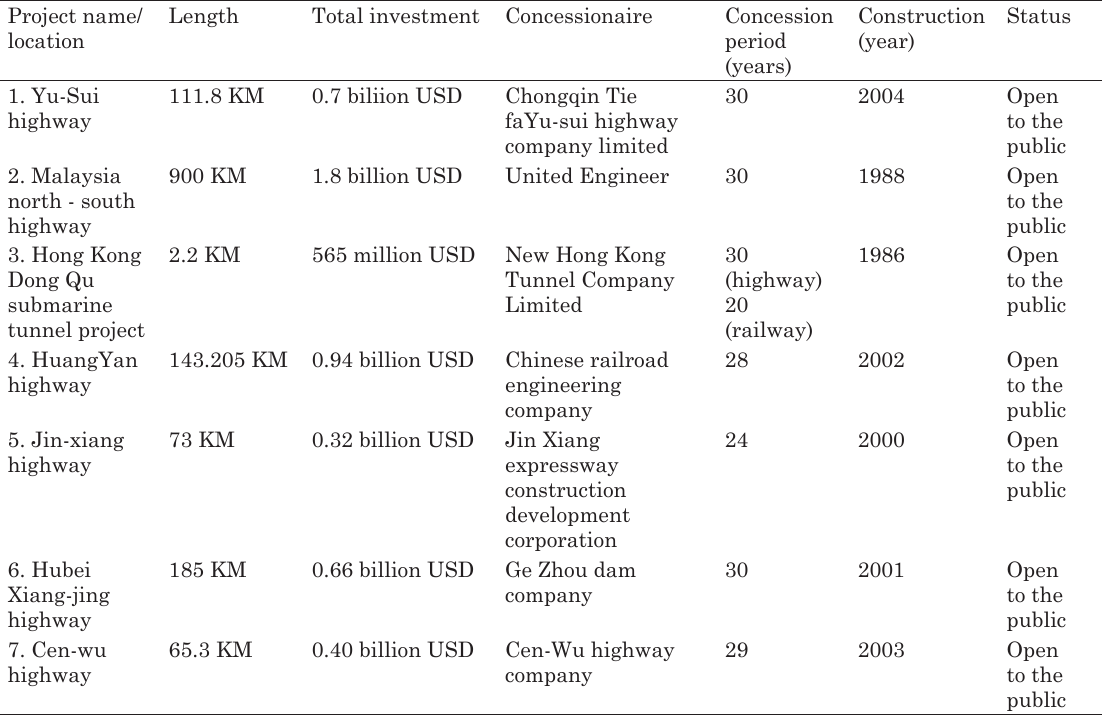
table 2. General information of the eight selected PPP highway projects Project name/